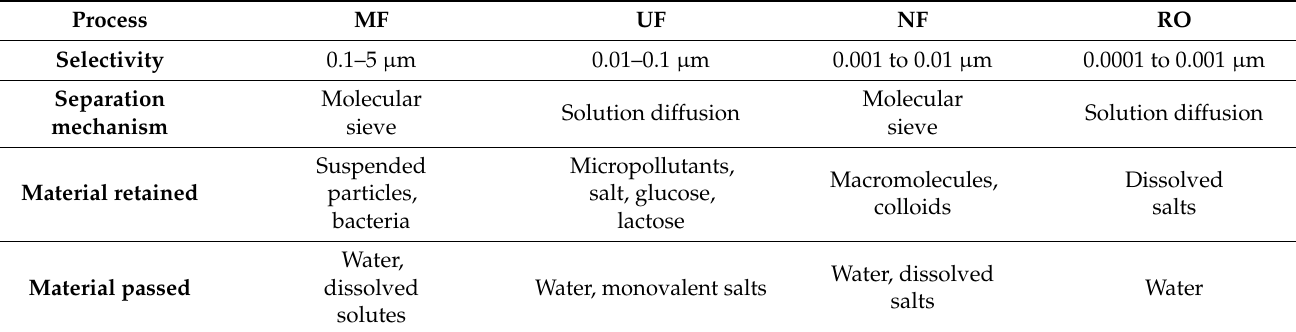
Table 2. Membrane separation process according to the pore size of the membrane (Adapted from